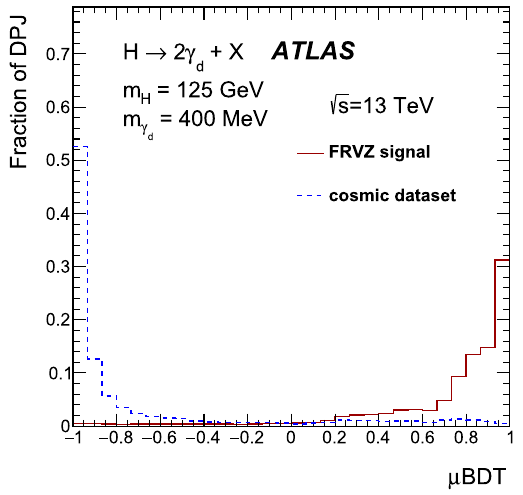
Fig. 2 BDT output distributions for signal and background for μ DPJs (left) and hDPJs (right). For muonic-DPJs the background is the cos- mic dataset and the FRVZ signal sample is the H → 2 γ d + X process